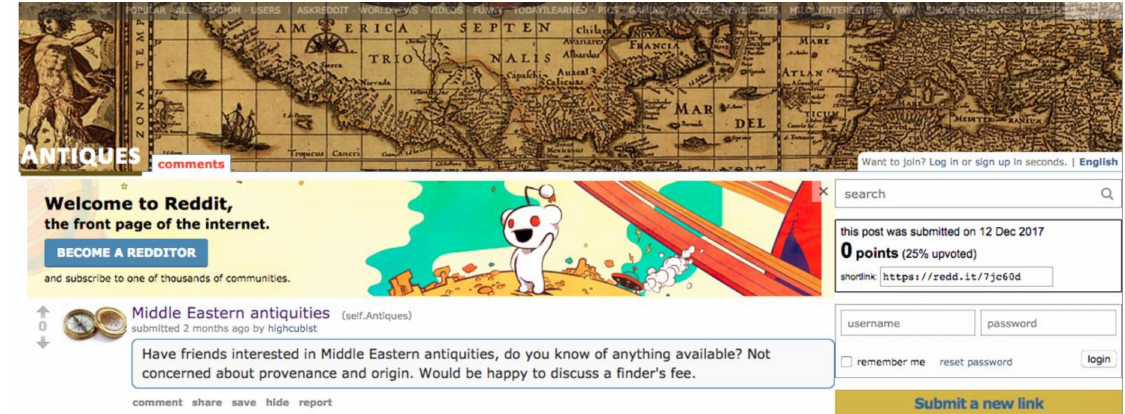
Figure 11. Screen grab of reddit user highcubist’s request for “Middle Eastern antiquities” in the subreddit for antiques (r/antiques), making clear they are not concerned about whether or not the object has provenance. (Screen grab by author 2018).